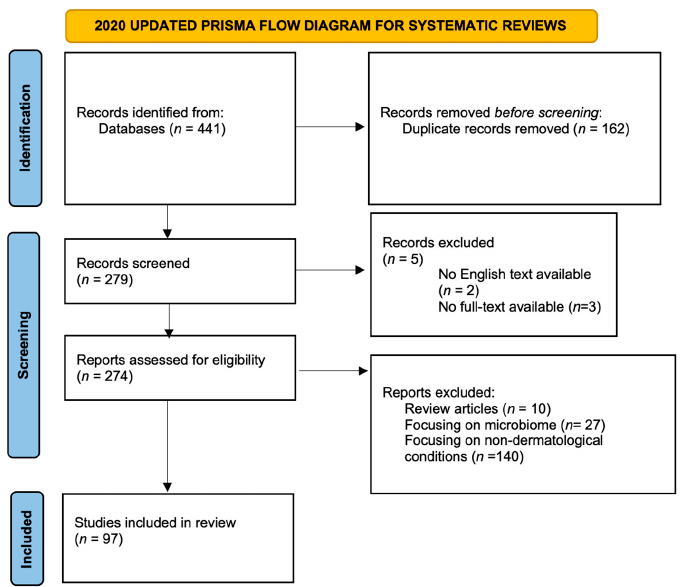
Figure 2. PRISMA flow diagram according to 2020 updated guidelines for systematic reviews. Table 1. List of the 97 papers retrieved with our search. Authors have been listed in alphabetical order. Journal names are abbreviated according to MedLine nomenclature.